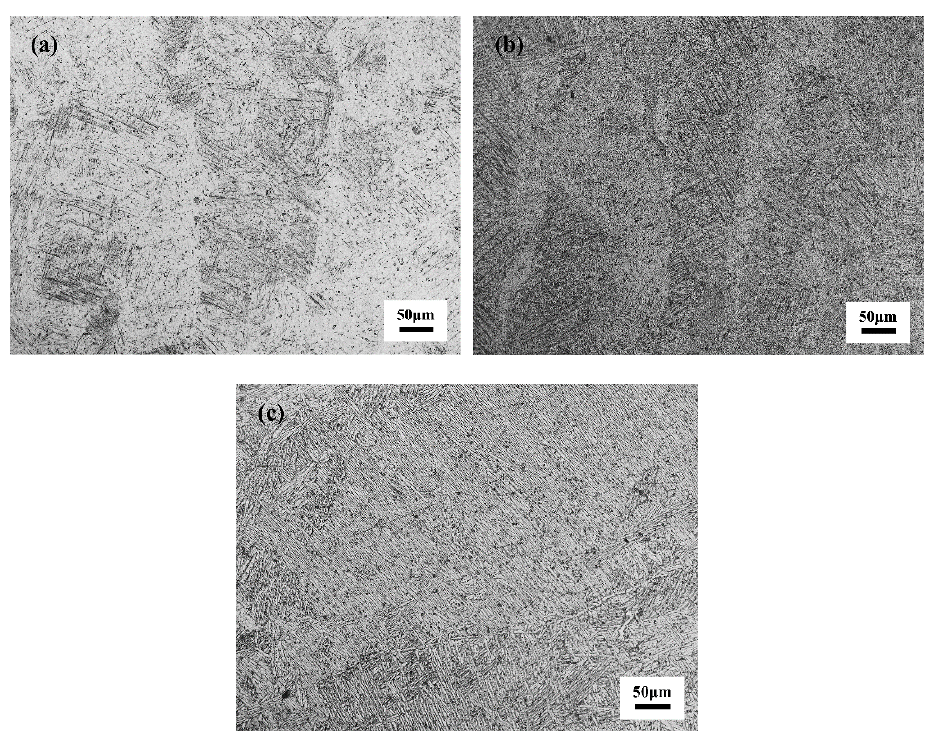
Figure 4. Microstructure of ( a ) as-built selective laser melting (SLM), ( b ) annealed SLM, and ( c ) wrought Ti – 6Al – 4V specimens.